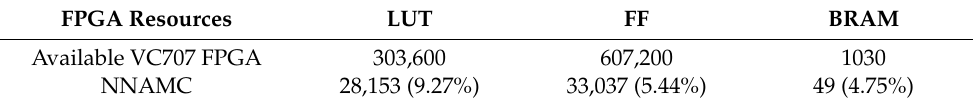
Table 4. Utilization of NNAMC’s hardware